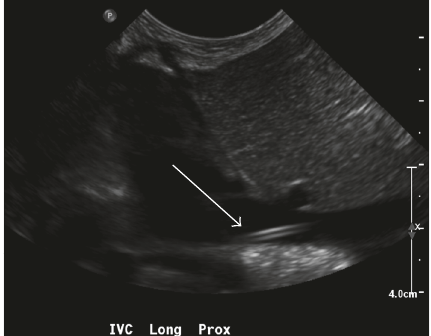
Figure 2: Sonographic imaging demonstrating the tip of the catheter (solid arrow) within the inferior vena cava (and not within the aorta). Also note that the size of the inferior vena cava is prominent.